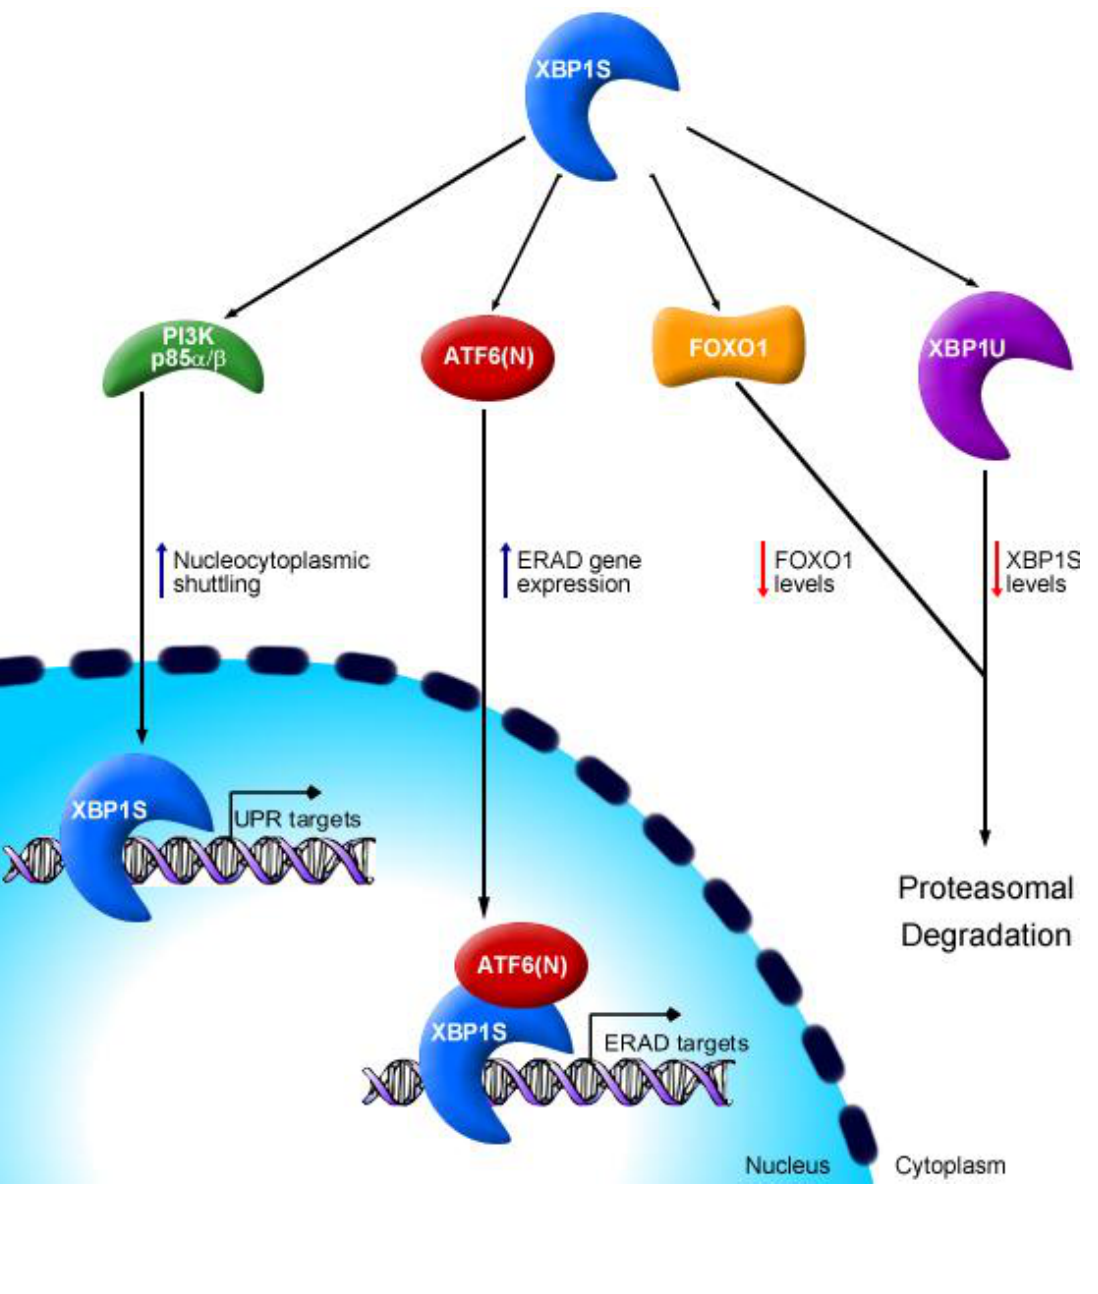
Figure 2. Binding partners of XBP1 proteins. The transcriptional activity of XBP1S is modulated through protein-protein interactions. The p85 (cid:68) / (cid:69) subunits of phosphatidylinositol 3-kinase (PI3K) bind to XBP1S and enhance its nuclear translocation. The active form of activating transcription factor 6 that traffics into the nucleus (ATF6(N)) interacts with XBP1S to exert a combinatorial effect on expression of ER-associated degradation (ERAD) components. Proteasome-mediated degradation of XBP1S is enhanced by direct interactions with both XBP1U and the transcription factor Forkhead box O1